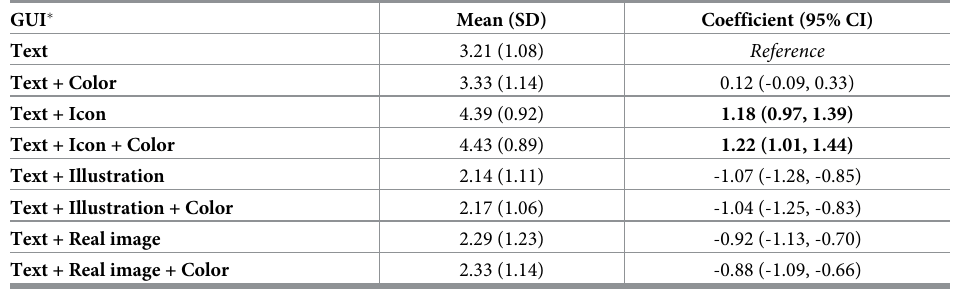
Table 2. Linear mixed linear regression model to compare the score of understanding of terms according to graphical user interface (GUI)